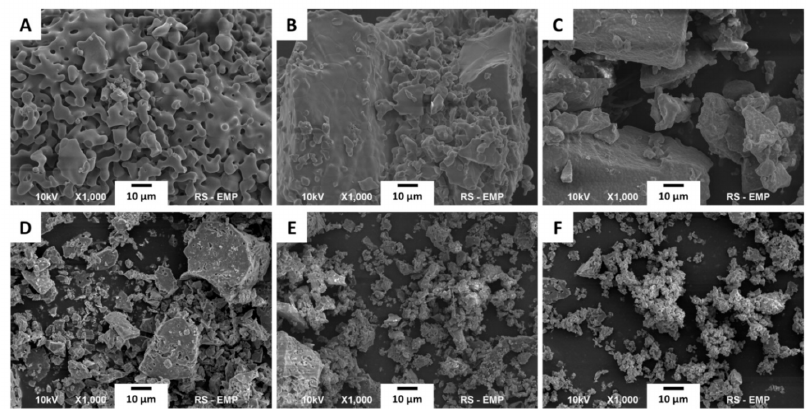
Figure 1. SEM microphotographs of the samples: 09Si-aTCP ( A ), 18Si-aTCP ( B ), 37Si-aTCP ( C ), 86 09Si-aTCP s ( D ), 18Si-aTCP s ( E ), and 37Si-aTCP s ( F ).